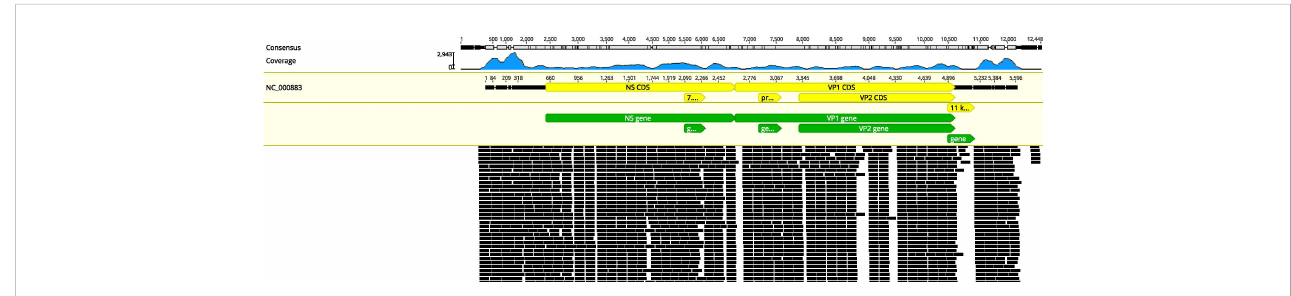
FIGURE 3 Results of next-generation sequencing in the peripheral blood. Mapping results of nucleotide sequences distributed along the genome of parvovirus B19 in the peripheral blood to parvovirus B19 reference genome